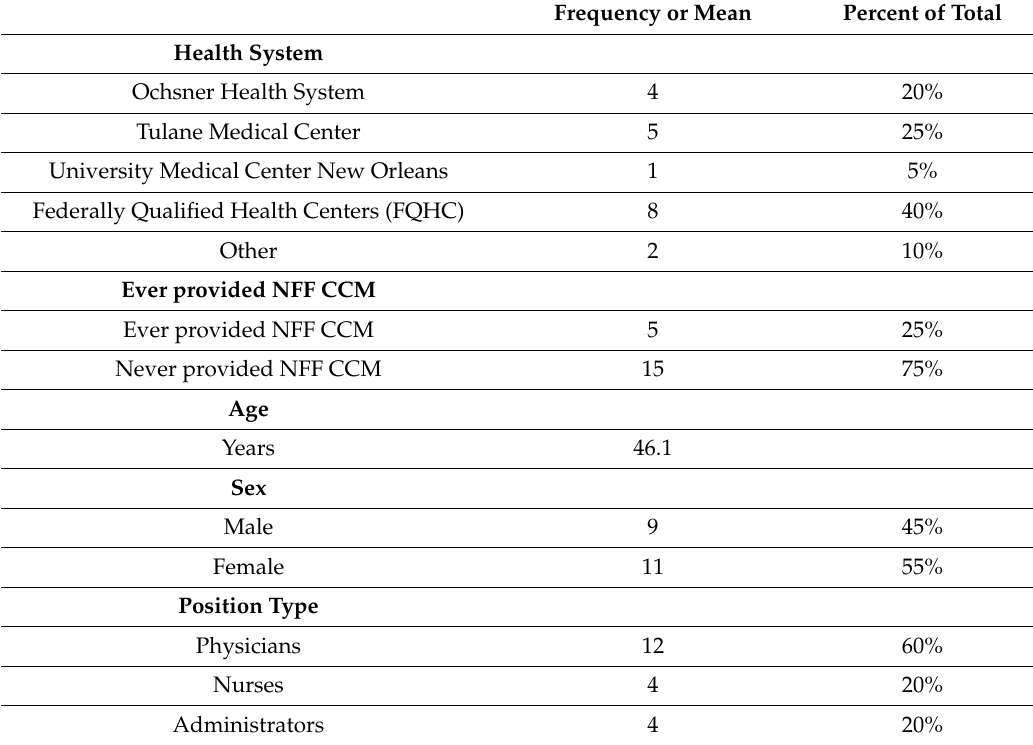
Table 1. Descriptive Information on Providers and Leaders Interviewed for the LEAD (Louisiana